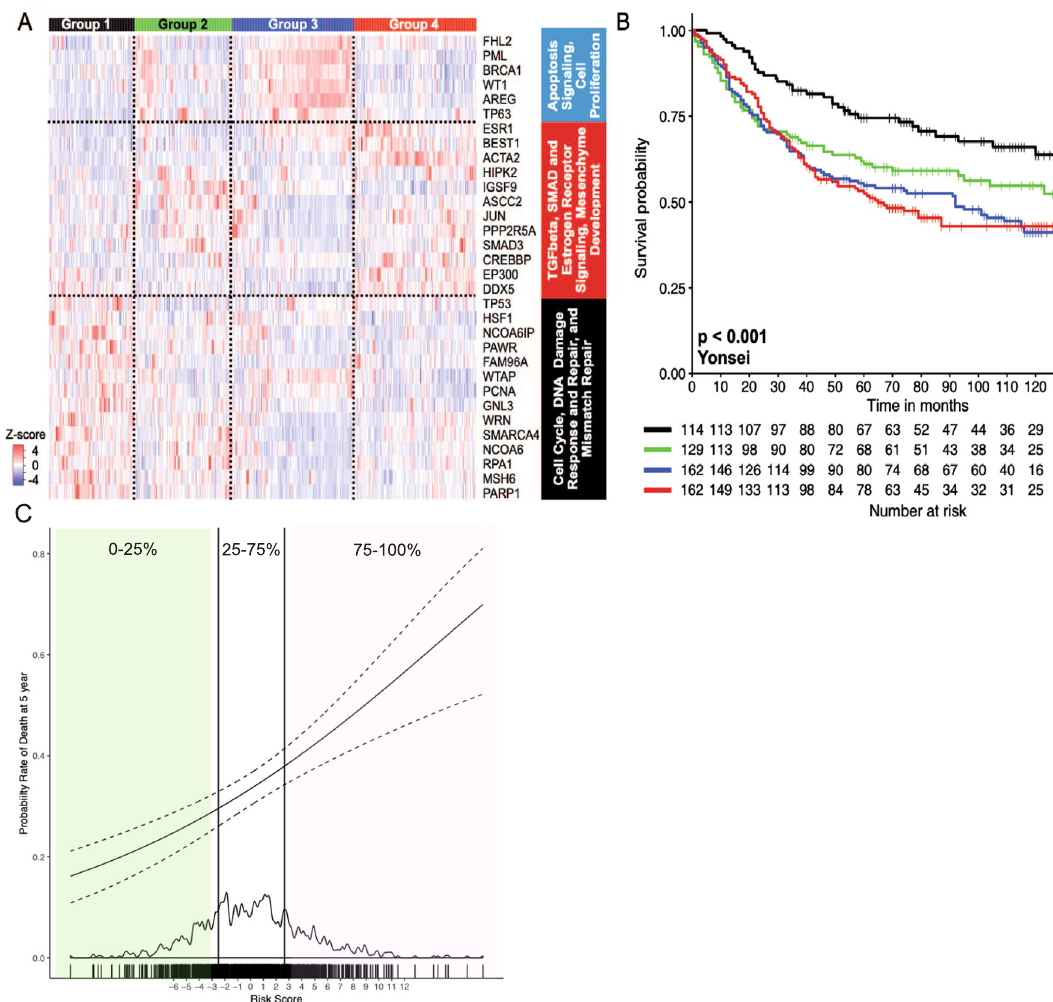
Fig. 2 The molecular subtypes were prognostic for overall survival. A Unsupervised consensus clustering using 32-gene signature identi fi ed four molecular subtypes in the Yonsei cohort. B Kaplan – Meier survival analysis of the four molecular subtypes in the Yonsei cohort. Survival was compared using the log-rank test. C The risk score was applied to the Asian Cancer Research Group (ACRG), Sohn et al., and The Cancer Genome Atlas (TCGA) cohorts as a combined group. The dashed curves indicate the 95% con fi dence interval. The rug plot on top of the x-axis shows the risk score for individual patients. The green region represents patients with scores below the 25 th percentile, the white area includes patients with scores from the 25 th to 75 th percentile, and the purple region includes patients with scores above the 75 th percentile. Source data are provided as a source data fi